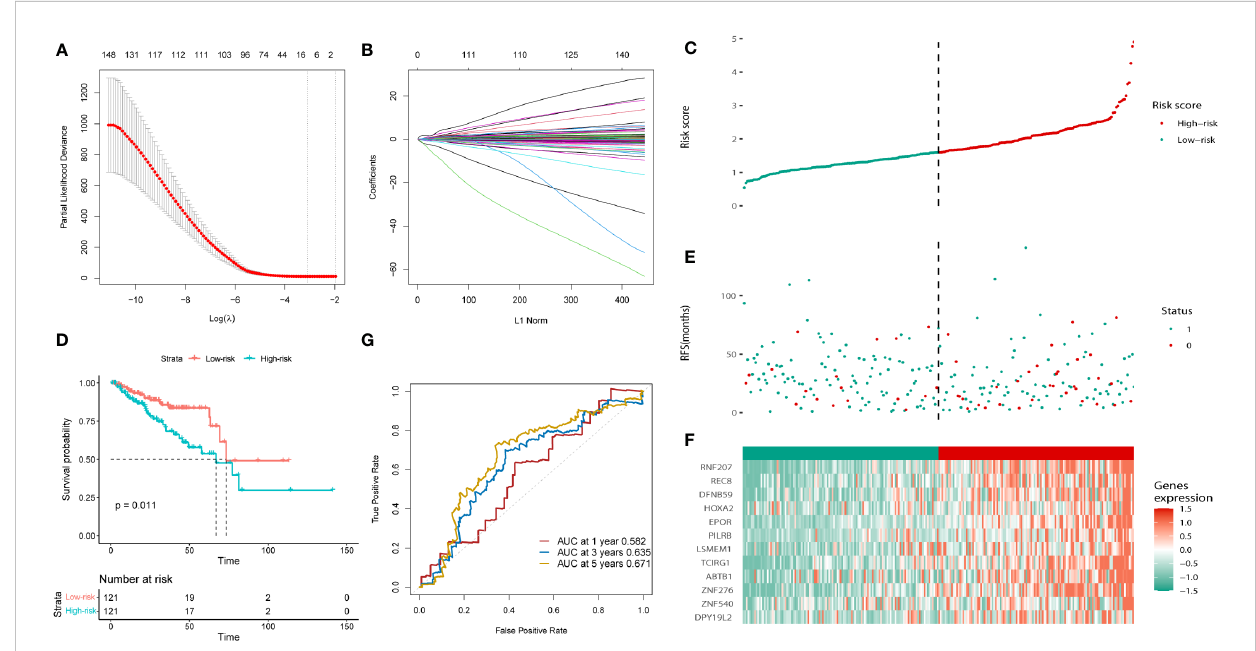
FIGURE 3 Construction of the bicalutamide-resistance gene-based risk prognostic model in the training cohort. (A, B) Construction of the LASSO regression model based on the 12 predictive genes. (C) Distribution of the risk scores. (D) The KM analysis of PFS in the high- and low-risk groups. (E) Survival status. (F) Expression of the 12 predictive genes. (G) ROC analysis to evaluate the predictive ef fi